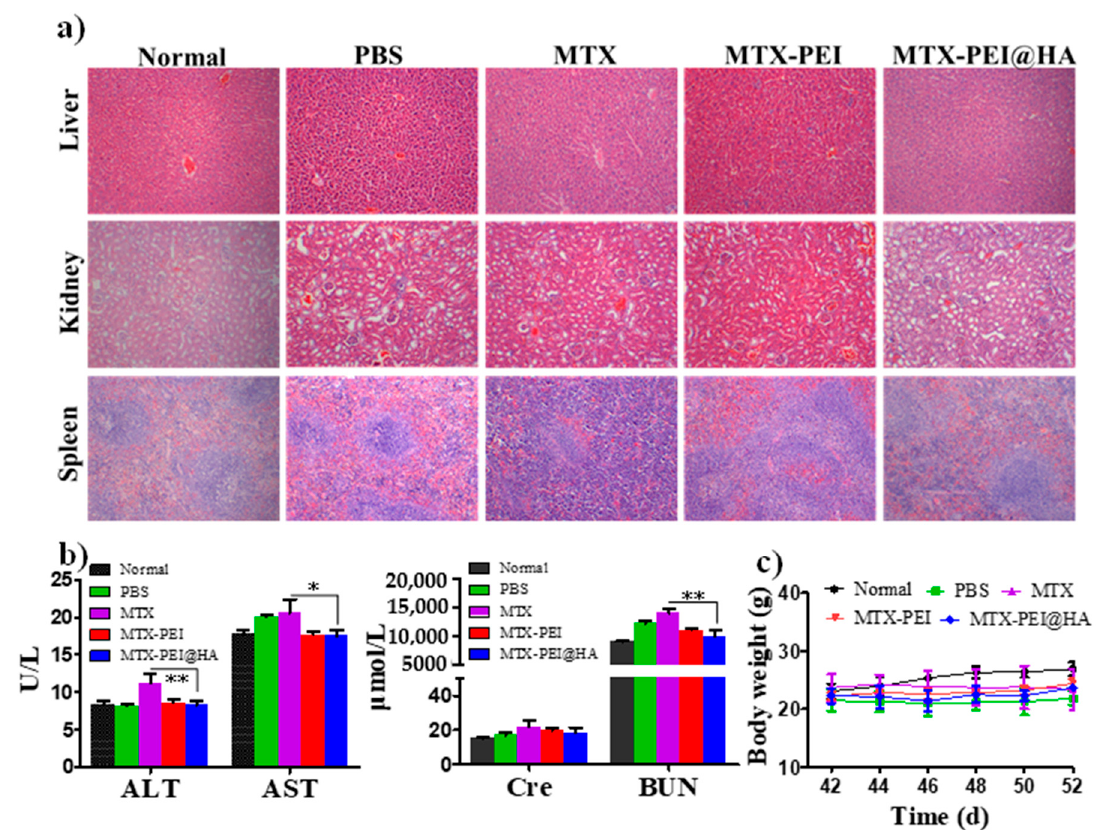
Figure 5. Systemic toxicity assessment of MTX-PEI@HA NPs. ( a ) H&E-stained images of liver, kidney and spleen. ( b ) Evaluation of the hepatotoxicity (according to the serum levels of alanine aminotransferase (ALT), aspartate aminotransferase (AST)) and nephrotoxicity (according to the serum levels of BUN and Cre) after different treatments. * p < 0.05, ** p < 0.01. ( c ) Body weight fluctuation of mice with different treatments during 10 days.